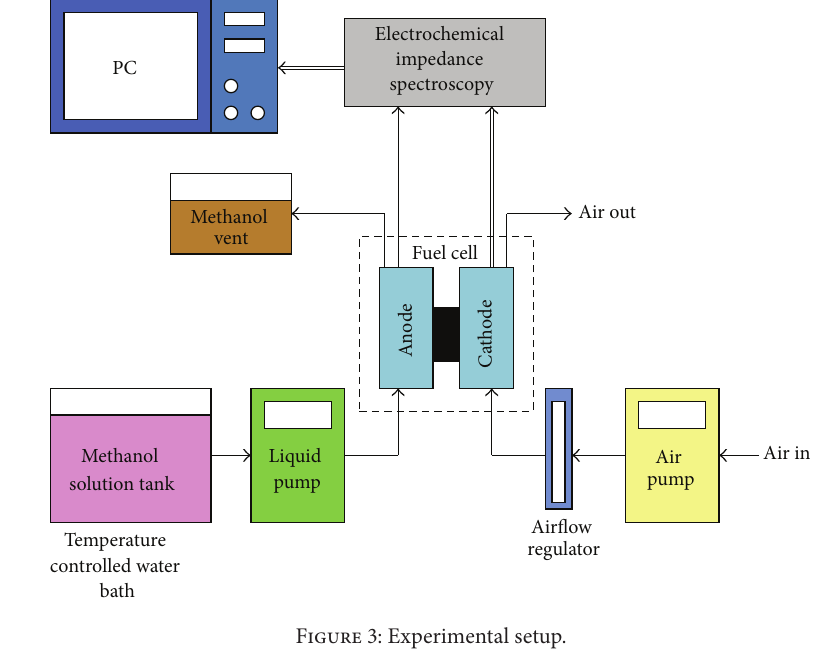
Figure 3: Experimental setup.